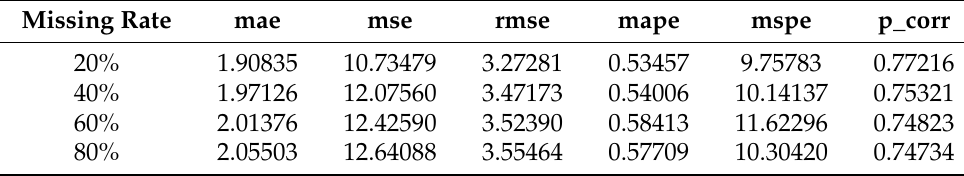
Table 3. The results of the informer-WGAN on the ETTh1 dataset. Missing Rate